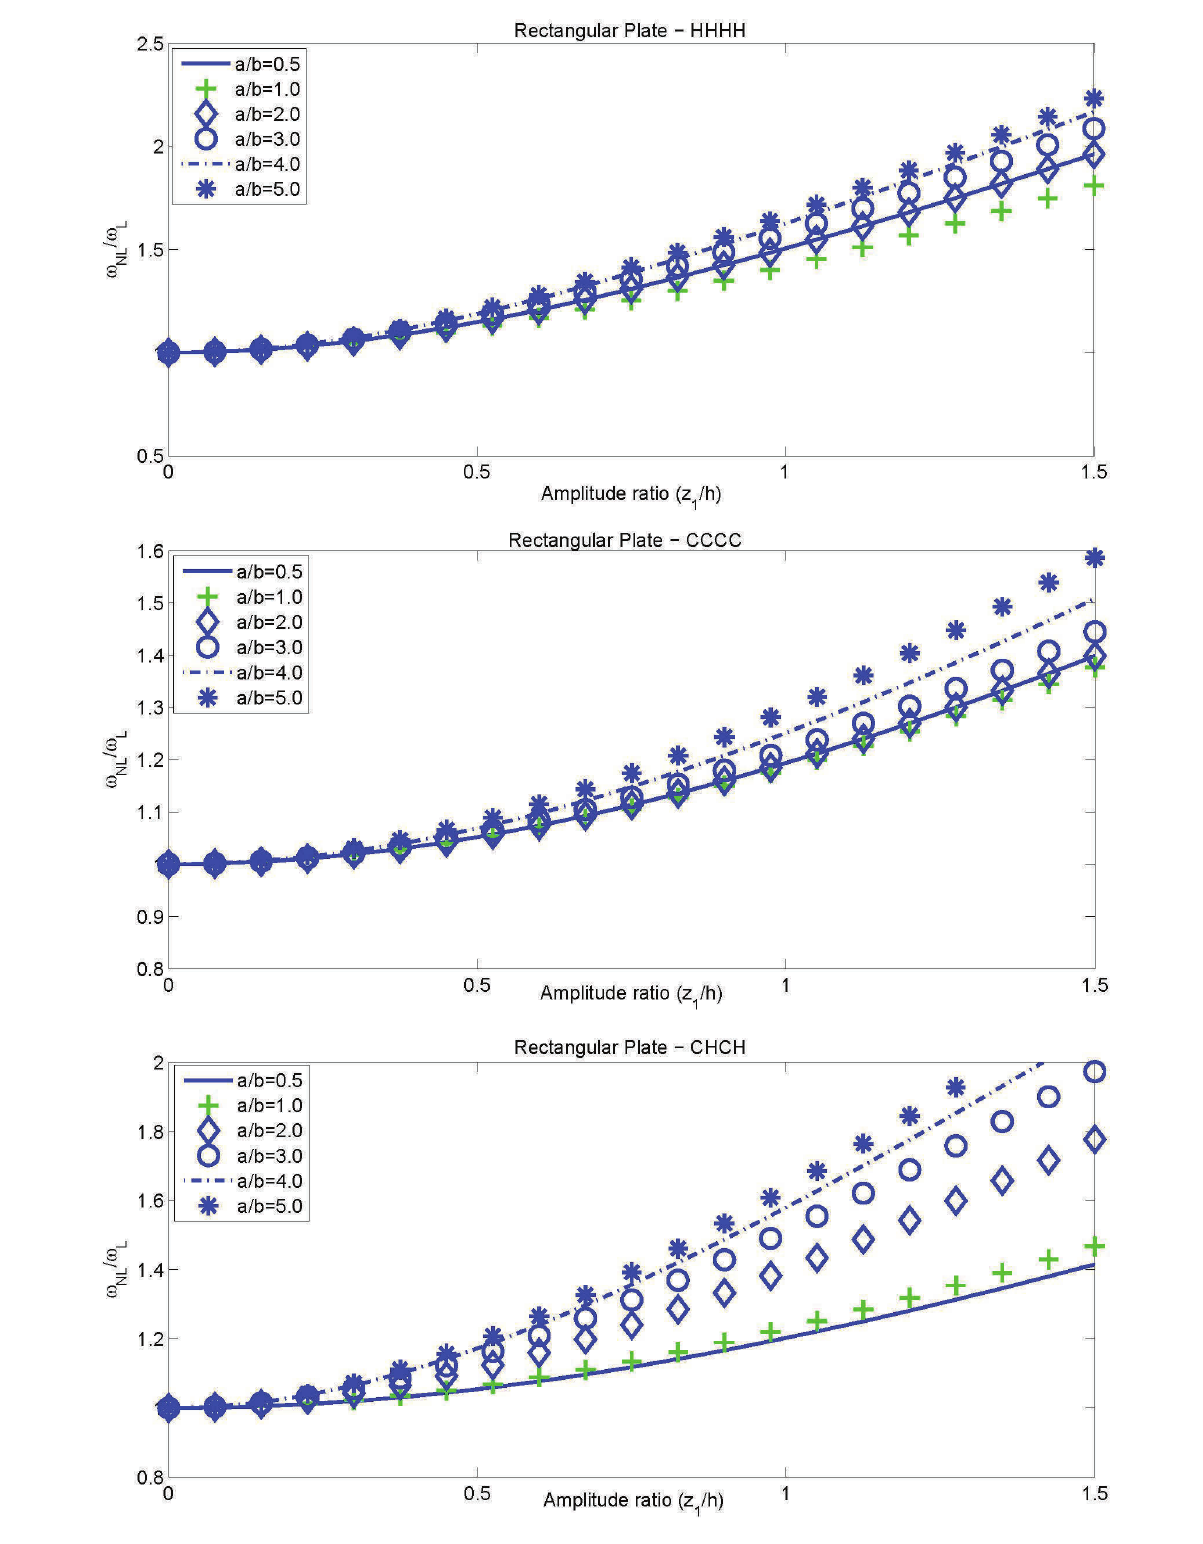
/ of various rectangular plates obtained by using the b